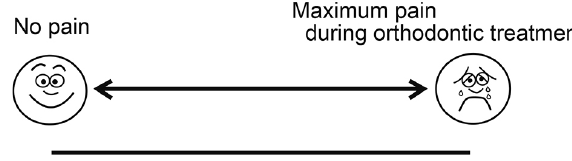
Figure 2- The visual analogue scale (VAS) used in this study. Patients drew a perpendicular line somewhere along the VAS according to the intensity of the pain felt